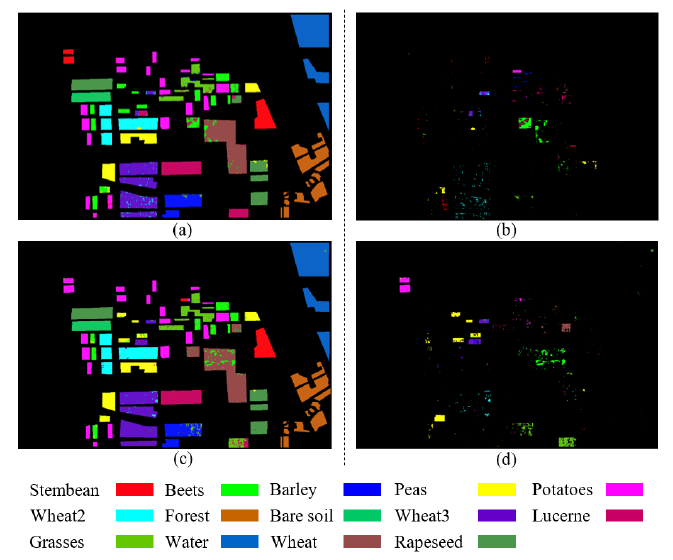
Figure 10. ( a , c ) represent the classification results of the Dual-CNN with slices of 11 × 11 and 19 × 19 respectively; ( b , d ) display the false results in ( a , c